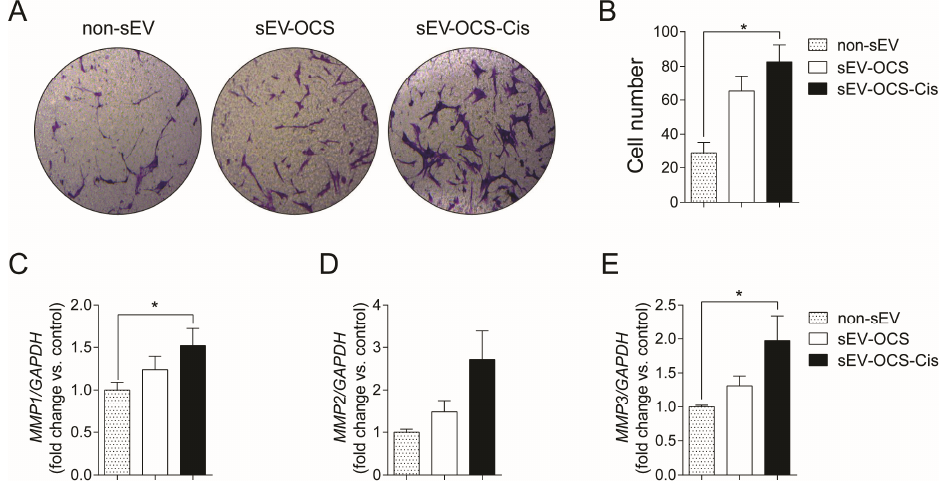
Figure 2. Migration of bone marrow mesenchymal stem cells (BM-MSCs) after stimulation with sEV-OCS or sEV-OCS-Cis. ( A ) Representative images of migration assay performed by transwell of BM-MSCs stimulated with sEV-OCS or sEV-OCS-Cis. ( B ) Quantification of BM-MSCs migration stimulated with sEV-OCS or sEV-OCS-Cis. Migrated cell numbers were determined by counting the number of cells contained in the photos of five different fields at original magnification 10x. ( C , D , E ) Relative fold change of ( C ) metalloproteinases 1 (MMP1), ( D ) MMP2, and ( E ) MMP3 expression of BM-MSCs stimulated with sEV-OCS or sEV-OCS-Cis measured by RT-qPCR. BM-MSCs without sEV stimulation (non-sEV) were used as a control in all the experiments. Results are mean ± SEM (standard error of the mean) of n = 4. Statistical analysis was performed using the Kruskal–Wallis test followed by Mann–Whitney test. * p < 0.05.